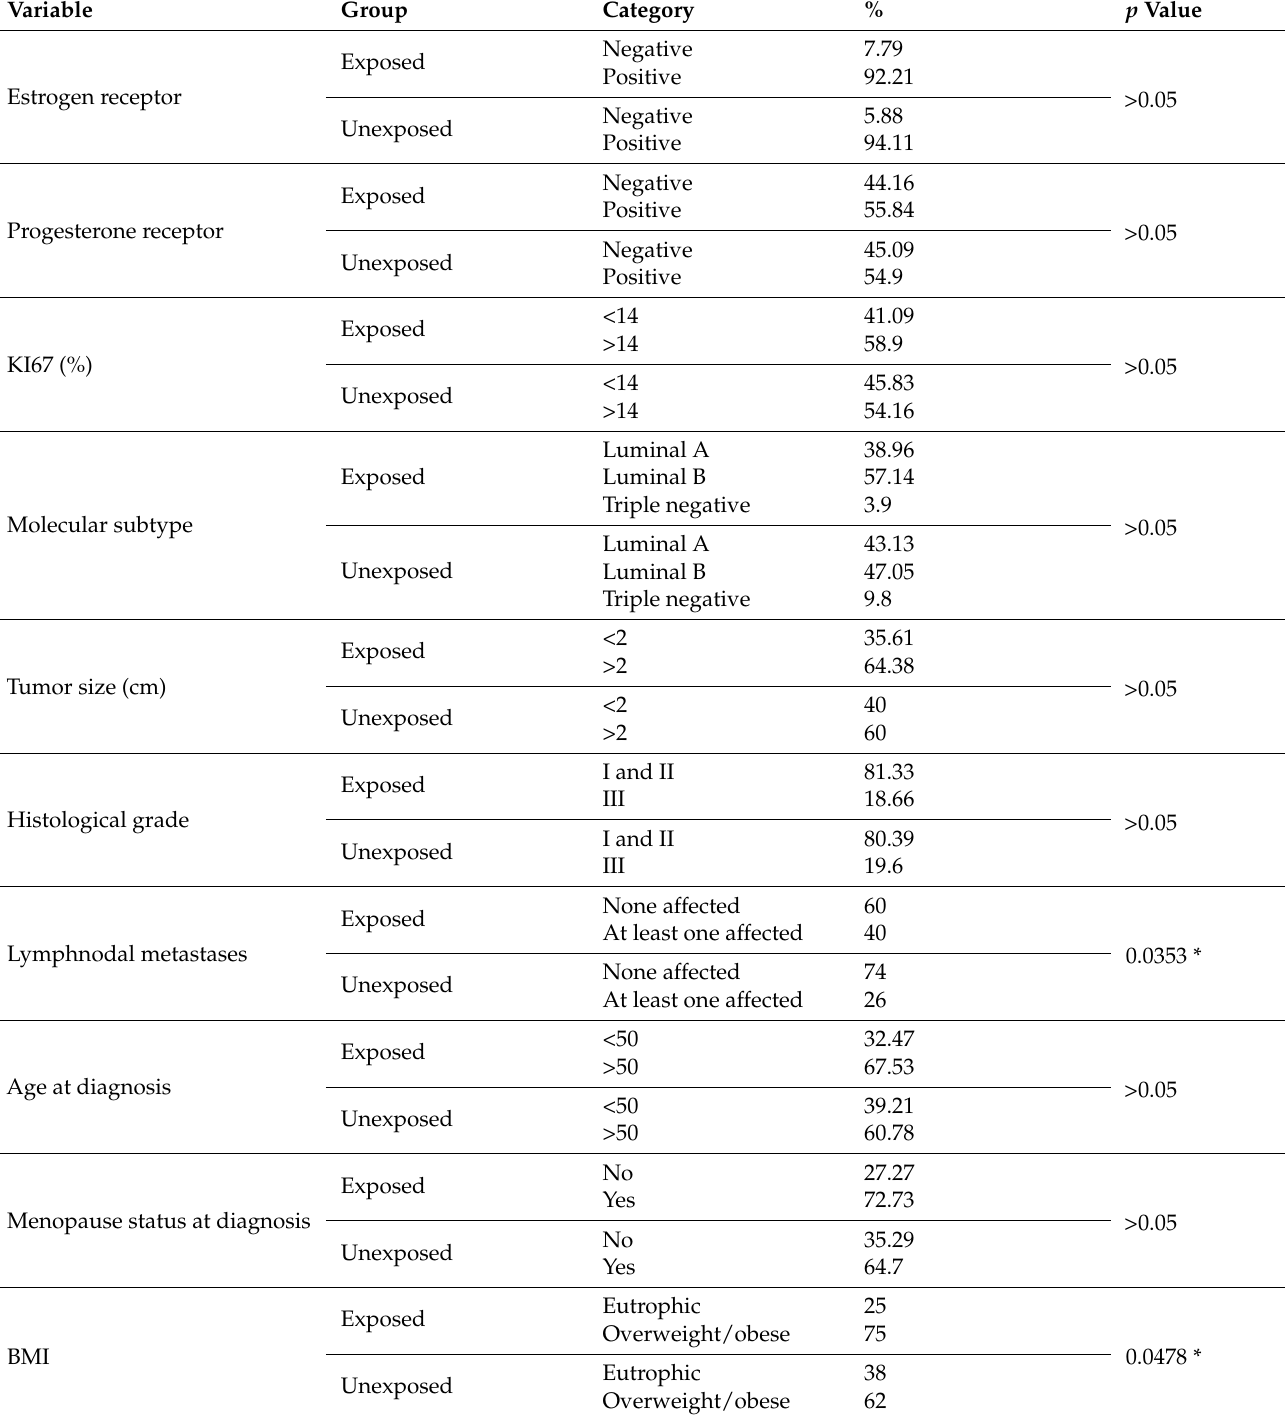
Table 3. Comparative analysis of clinicopathological data of exposed and unexposed breast cancer patients from intermediate-risk